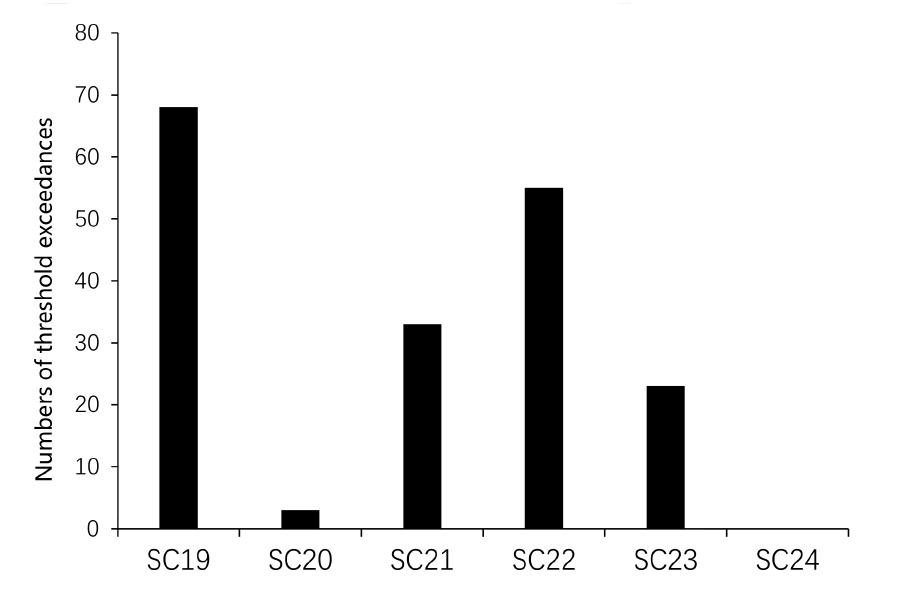
Figure 7. Threshold exceedances histogram, indicating the distribution over the last six SCs included 182 exceedances in the daily